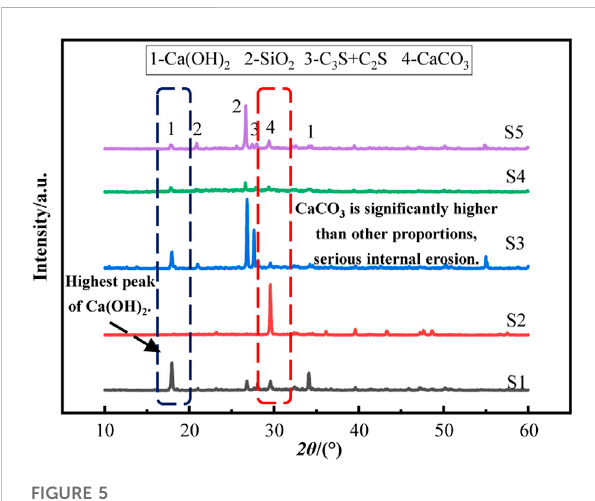
FIGURE 5 XRD patterns of each ratio before